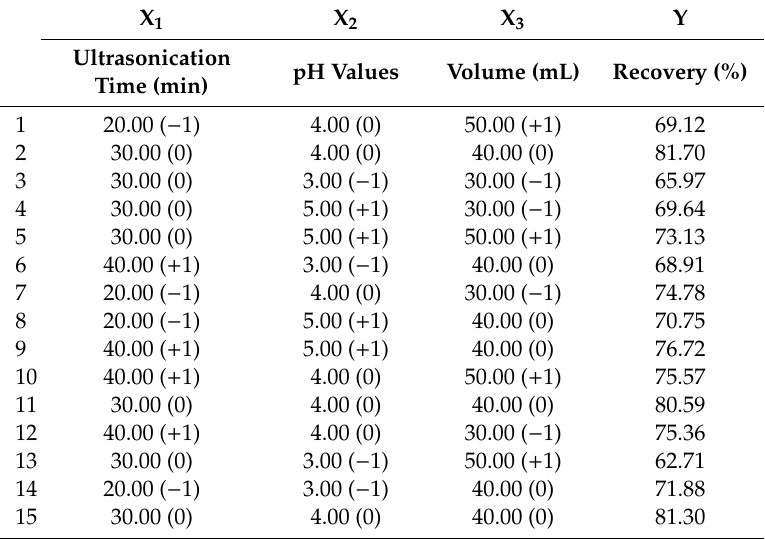
Table 2. Response surface methodology (RSM) optimization design and results of the average recoveries of SMZ and